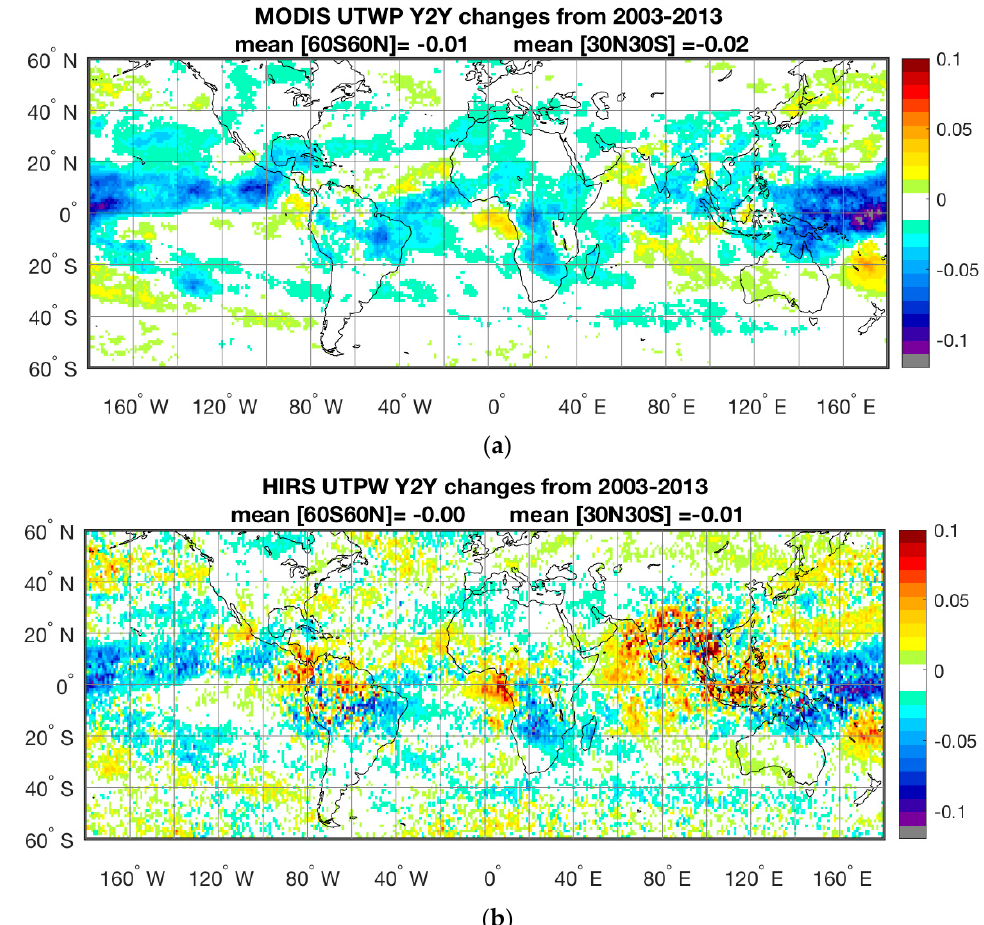
Figure 10. ( a ) MODIS Aqua mean year to year change in UTPW from 2003 to 2013. The same months are used as in the HIRS data below. Spatial resolution is one degree. ( b ) HIRS mean year to year change TPW from 2003 to 2013. Spatial resolution is 1 degree. Data from the HIRS sensors on NOAA-16, -18, and -19 are included. Same sensor detection of UTPW differences for the same month from one year to the next are computed separately for all twelve months and then aggregated over the years 2003–2013; averages are taken over all months to infer mean changes. Overall mean for Tropics (denoted by [30N30S]) and for the 60° S and 60° N latitude band (denoted by [60S60N]) are in the subtitles.